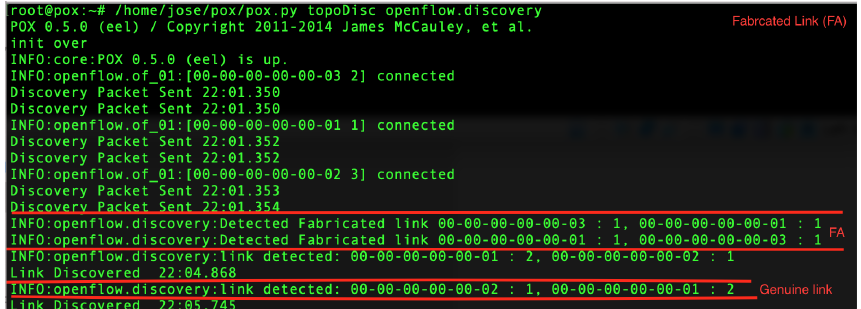
Figure 10. Fabricated link